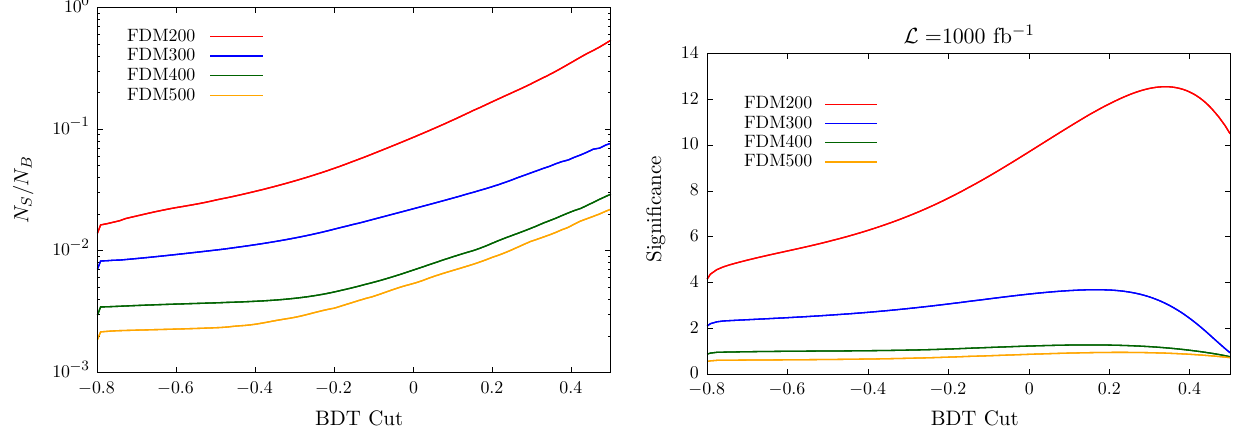
Fig. 6 Left: the signal-to-background ratio with varying BDT cut for FDM benchmark points. Right: the signal significance at the ILC with integrated luminosity of 1000 fb − 1